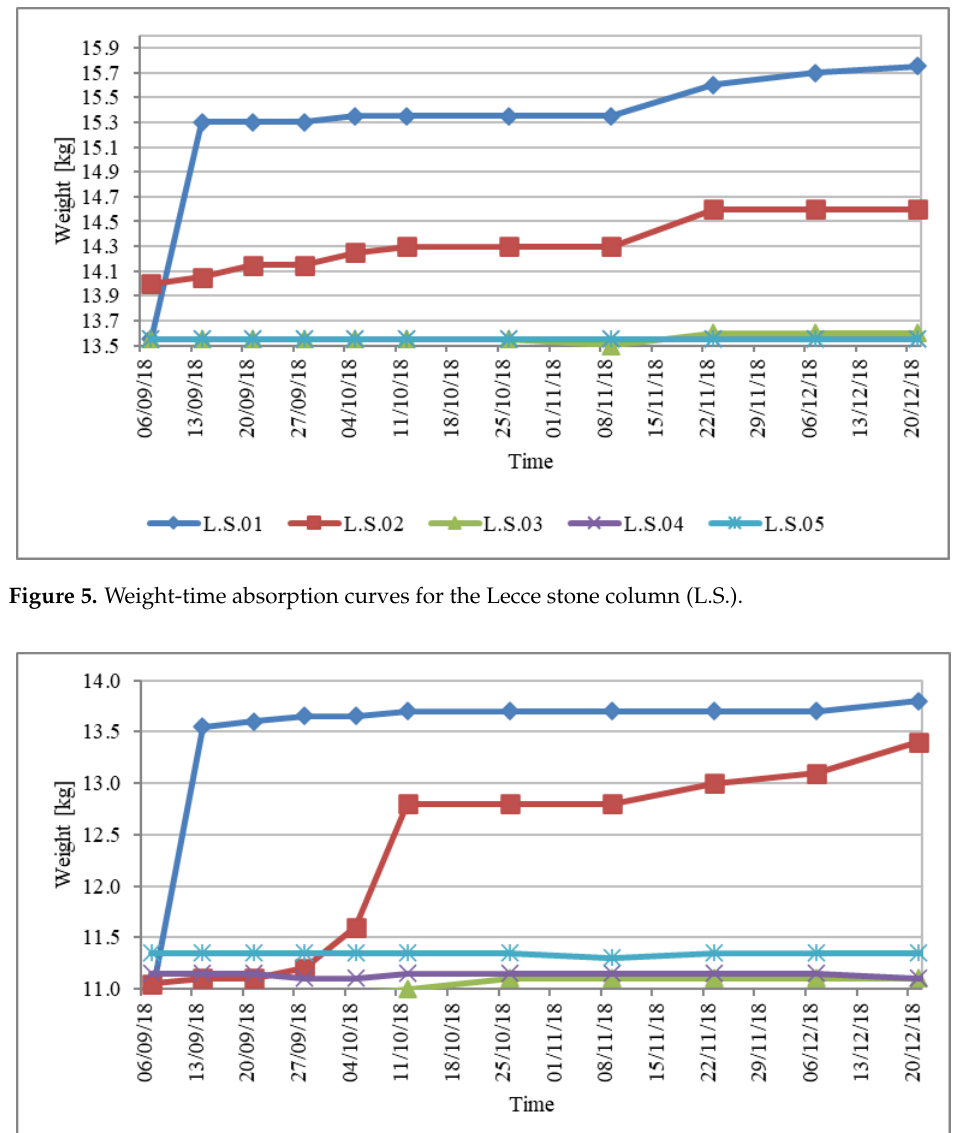
Figure 4. Weight-time absorption curves for the carparo column (C.).